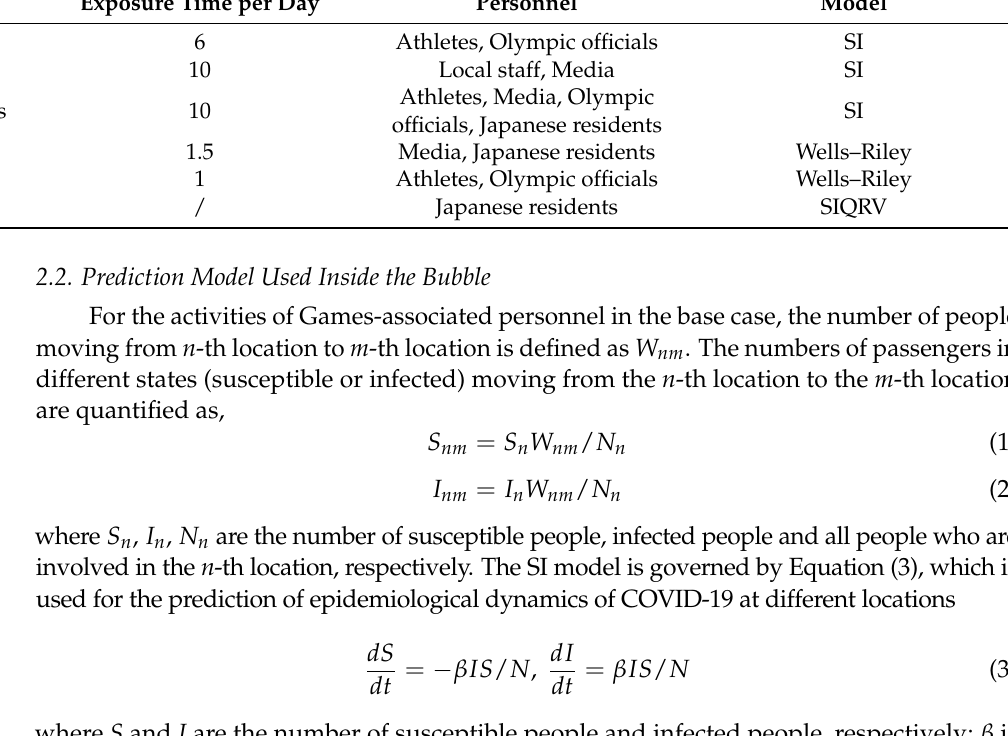
Figure 2. Persons identified in different groups (indicated by different colors) come into contact at different locations and through different transportation modes (indicated by different colors and shapes) during a day.